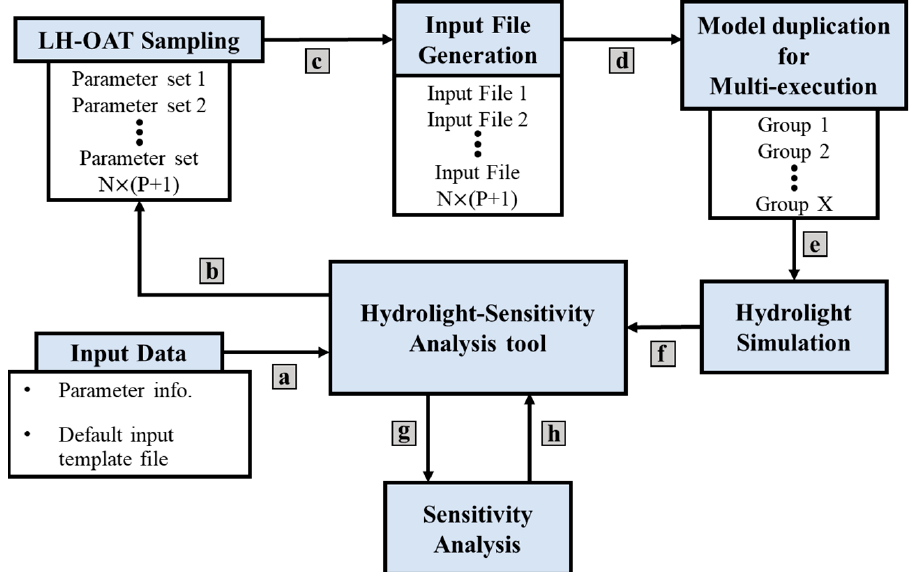
Figure 2. Schematic for program workflow—( a ) is a model parameter and input template load; ( b ) is the Latin hypercube and one-factor-at-a-time (LH–OAT) sampling implementation for the parameters; ( c ) is the total input generated based on observation data and LH–OAT sampling results; ( d ) is the preparation for multiple executions by duplicating the model set as a group; ( e ) is the multi-point HydroLight simulation; ( f ) is the load of the simulated reflectance profile; ( g ) is the implementation of parameter sensitivity analysis by comparing simulated reflectance with direct observation; and ( h ) is the display of the sensitivity analysis result.